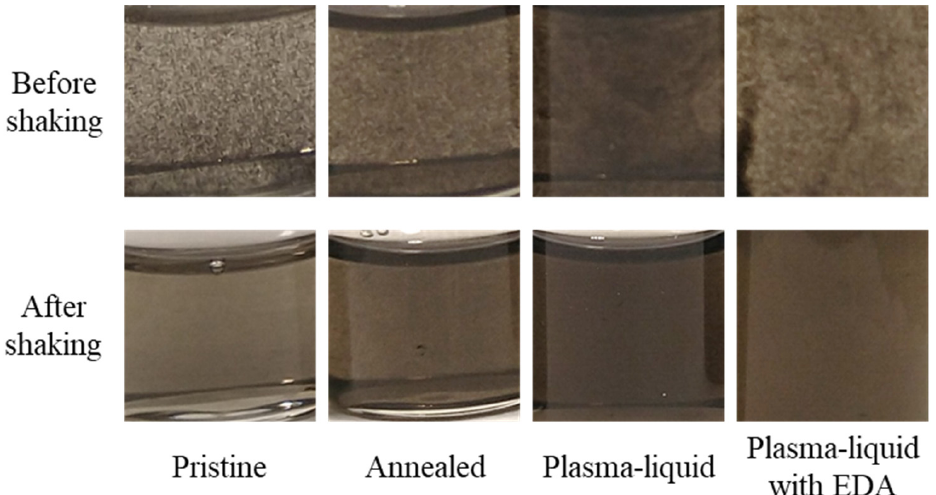
Figure 7. Photographs of the nanofluids after 809 days of storage before shaking, and after 2 vigorous shakes by hand. Note that the photographs have been modified to enhance the contrast and brightness to highlight flocculation.